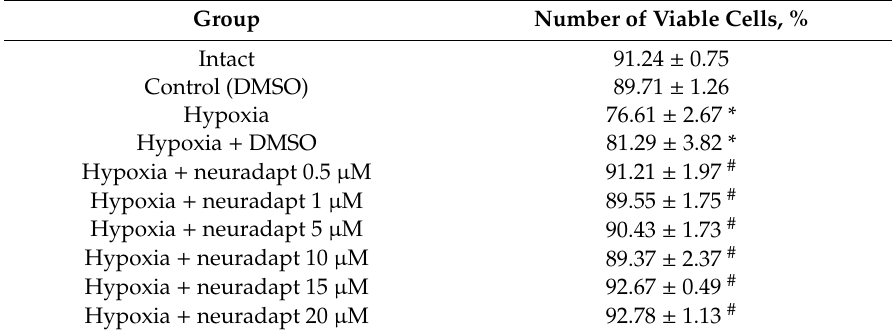
Table 2. Cell viability of primary hippocampal cultures on day 7 post-hypoxia modeling with immediate neuradapt